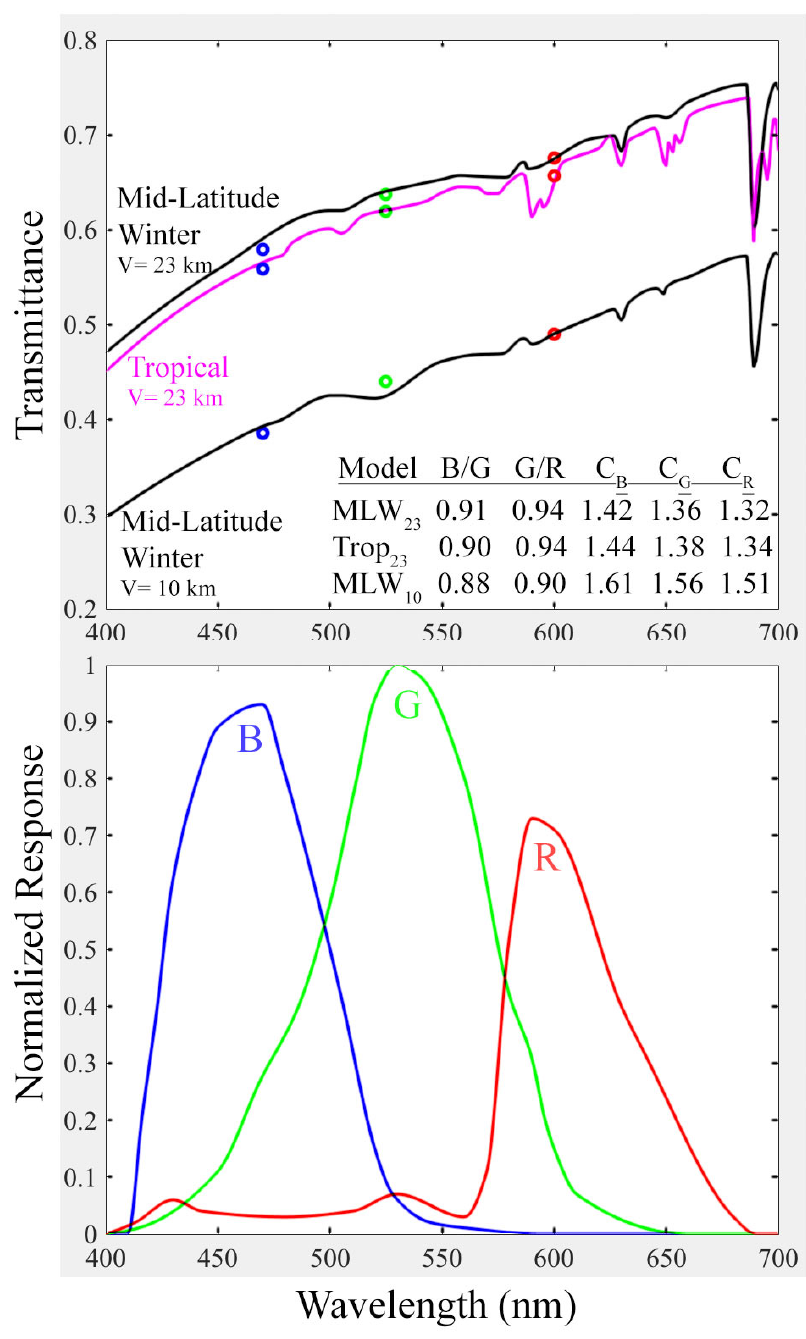
Figure 4. Atmospheric transmittance correction estimation. Nikon D3S spectral responses ( bottom ) are convolved with MODTRAN-derived atmospheric transmittance ( top ) for different visibilities and atmosphere models to produce response-weighted channel-specific estimates (circles) for transmittance loss corrections (C BGR ).